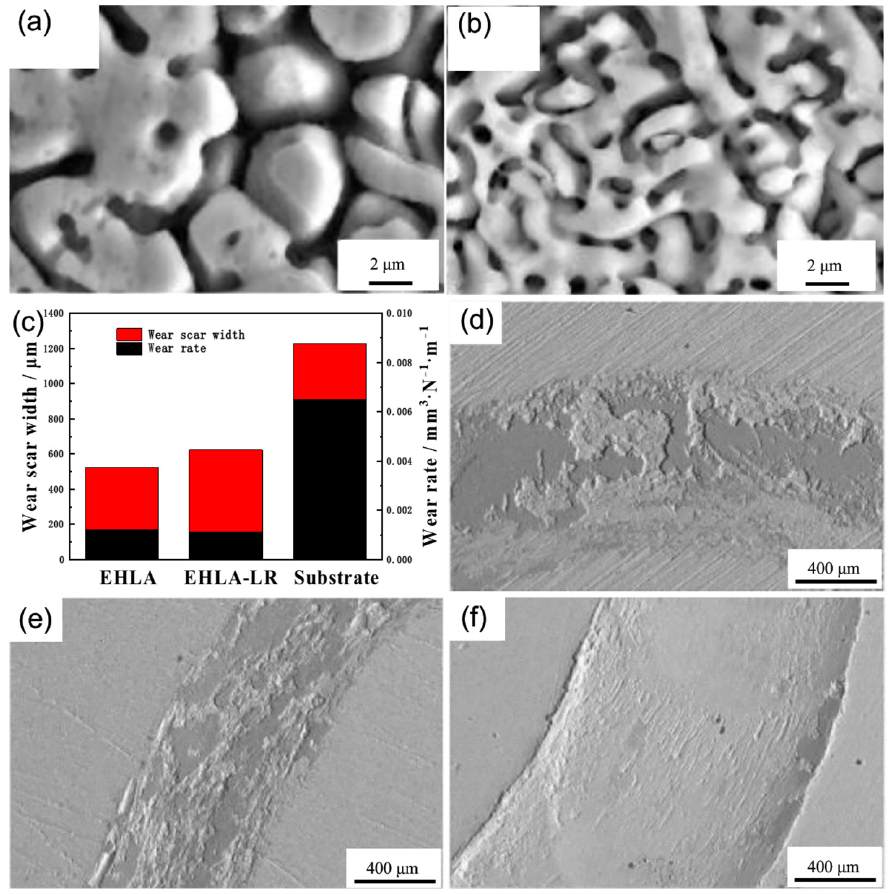
Figure 13. Cross-sectional SEM microstructure in near surface region: ( a ) EHLA; ( b ) EHLA-LR; Wear test results: ( c ) Wear scar width and wear rate; ( d ) Wear appearance of EHLA; ( e ) Wear appearance of EHLA-LR; ( f ) Wear appearance of the substrate [58].